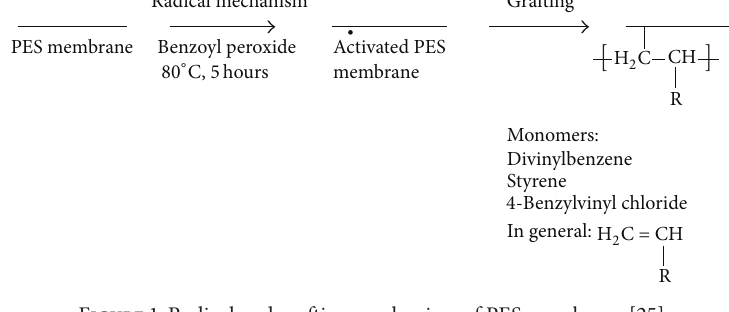
Figure 1: Radical and grafting mechanism of PES membrane [25].